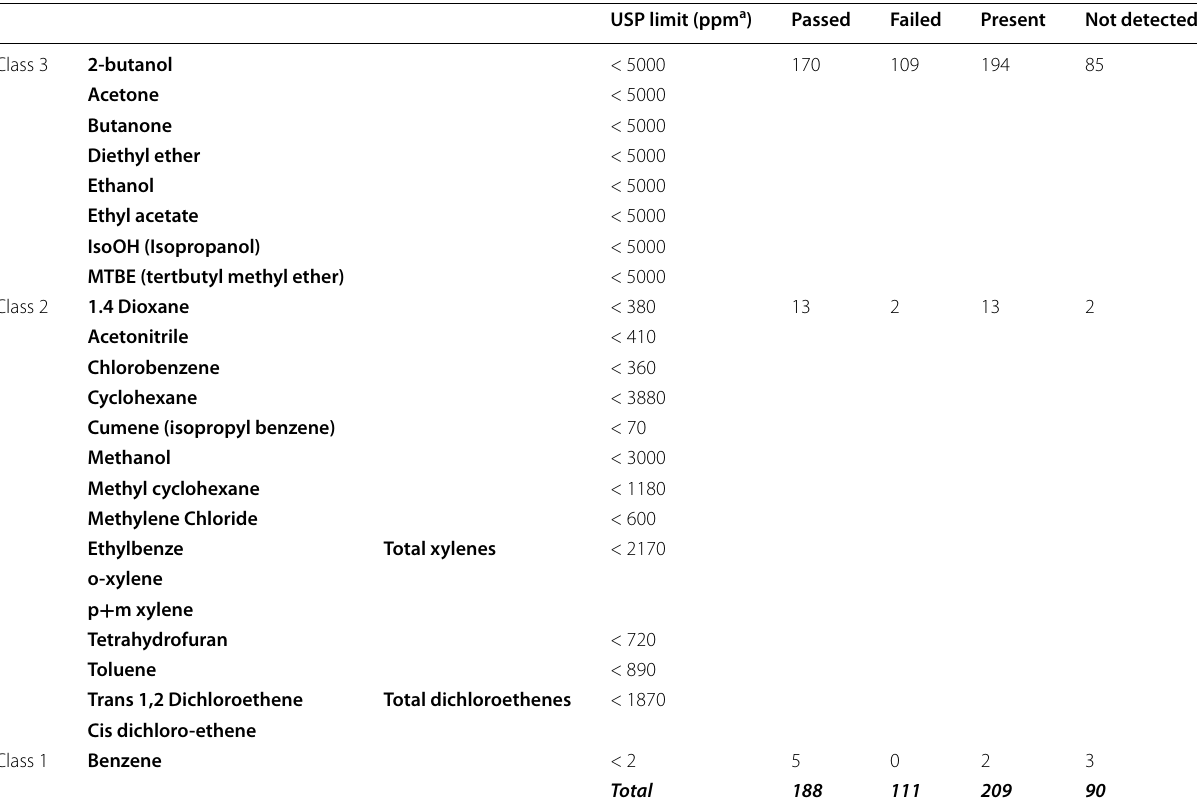
Table 4 Number of sample failures and the occurrence of solvents in